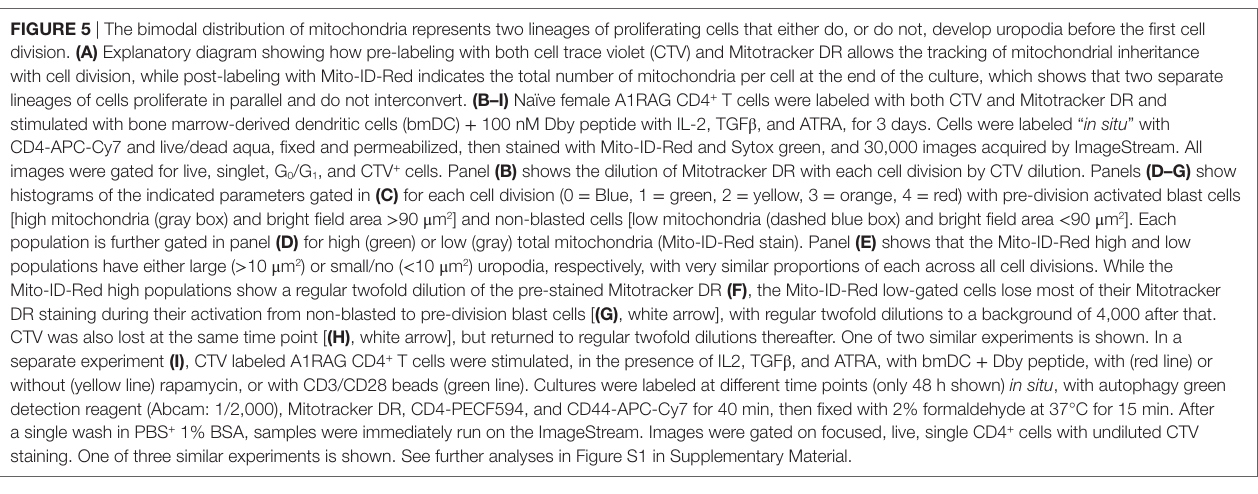
FigUre 5 | The bimodal distribution of mitochondria represents two lineages of proliferating cells that either do, or do not, develop uropodia before the first cell division. (a) Explanatory diagram showing how pre-labeling with both cell trace violet (CTV) and Mitotracker DR allows the tracking of mitochondrial inheritance with cell division, while post-labeling with Mito-ID-Red indicates the total number of mitochondria per cell at the end of the culture, which shows that two separate lineages of cells proliferate in parallel and do not interconvert. (b–i) Naïve female A1RAG CD4 + T cells were labeled with both CTV and Mitotracker DR and stimulated with bone marrow-derived dendritic cells (bmDC) + 100 nM Dby peptide with IL-2, TGF β , and ATRA, for 3 days. Cells were labeled “ in situ ” with CD4-APC-Cy7 and live/dead aqua, fixed and permeabilized, then stained with Mito-ID-Red and Sytox green, and 30,000 images acquired by ImageStream. All images were gated for live, singlet, G 0 /G 1 , and CTV + cells. Panel (b) shows the dilution of Mitotracker DR with each cell division by CTV dilution. Panels (D–g) show histograms of the indicated parameters gated in (c) for each cell division (0 = Blue, 1 = green, 2 = yellow, 3 = orange, 4 = red) with pre-division activated blast cells [high mitochondria (gray box) and bright field area > 90 μ m 2 ] and non-blasted cells [low mitochondria (dashed blue box) and bright field area < 90 μ m 2 ]. Each population is further gated in panel (D) for high (green) or low (gray) total mitochondria (Mito-ID-Red stain). Panel (e) shows that the Mito-ID-Red high and low populations have either large ( > 10 μ m 2 ) or small/no ( < 10 μ m 2 ) uropodia, respectively, with very similar proportions of each across all cell divisions. While the Mito-ID-Red high populations show a regular twofold dilution of the pre-stained Mitotracker DR (F) , the Mito-ID-Red low-gated cells lose most of their Mitotracker DR staining during their activation from non-blasted to pre-division blast cells [ (g) , white arrow], with regular twofold dilutions to a background of 4,000 after that. CTV was also lost at the same time point [ (h) , white arrow], but returned to regular twofold dilutions thereafter. One of two similar experiments is shown. In a separate experiment (i) , CTV labeled A1RAG CD4 + T cells were stimulated, in the presence of IL2, TGF β , and ATRA, with bmDC + Dby peptide, with (red line) or without (yellow line) rapamycin, or with CD3/CD28 beads (green line). Cultures were labeled at different time points (only 48 h shown) in situ , with autophagy green detection reagent (Abcam: 1/2,000), Mitotracker DR, CD4-PECF594, and CD44-APC-Cy7 for 40 min, then fixed with 2% formaldehyde at 37°C for 15 min. After a single wash in PBS + 1% BSA, samples were immediately run on the ImageStream. Images were gated on focused, live, single CD4 + cells with undiluted CTV staining. One of three similar experiments is shown. See further analyses in Figure S1 in Supplementary